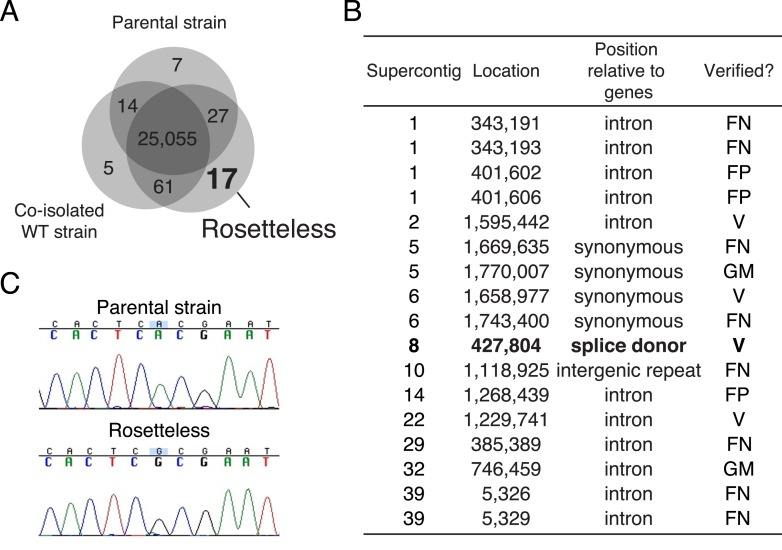
Identification of Rosetteless-specific mutations.(A) Venn diagram of the high-quality single nucleotide variants (SNVs) detected in the genome sequences of Rosetteless, the parental strain, and a co-isolated wild-type strain as compared to the S. rosetta reference genome. The vast majority of detected SNVs (25,055) were shared among all three isolates. Only 17 unique, high-quality SNVs were predicted in Rosetteless. (B) The seventeen predicted, Rosetteless-specific SNV calls. Genotyping of Rosetteless and wild-type S. rosetta was used to determine whether the putative unique SNV was verified (V, present in Rosetteless but absent in wild type), a false positive (FP, absent from both Rosetteless and wild type), a false negative (FN, present in both Rosetteless and wild type), or a mistakenly called SNV in a region where the S. rosetta reference genome was misassembled (GM). The SNV on supercontig 8 (bold) was the only one predicted to alter a coding region. (C) Cloning and Sanger sequencing confirmed that the supercontig 8: 427,804 SNV was polymorphic between Rosetteless and the parental strain. Note that the Sanger sequencing shown here was from the + strand, while the gene is encoded on the—strand.